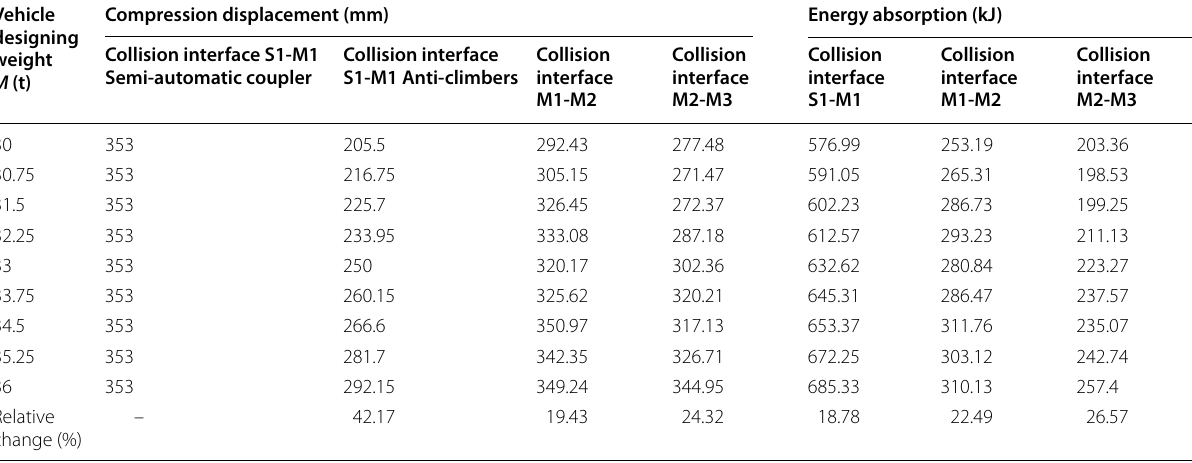
Table 6 Collision responses of the energy-absorbing devices under different vehicle design collision weights M Vehicle designing